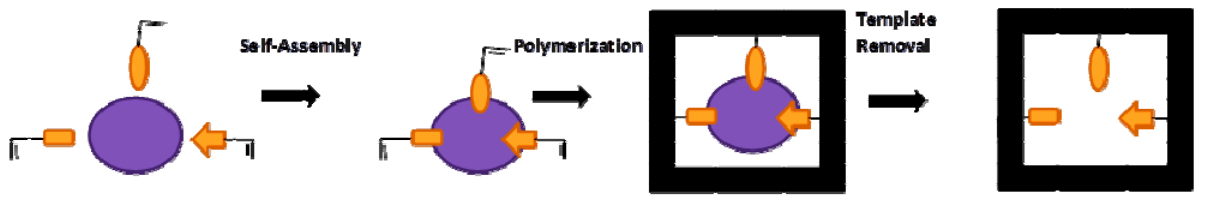
Figure 1. Schematic diagram of molecular